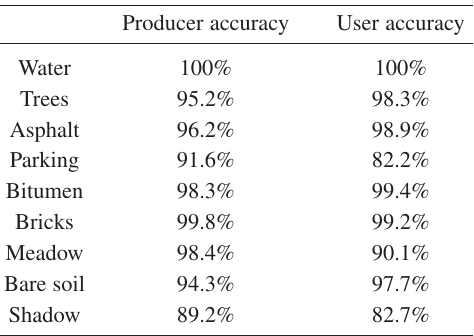
Table III. Accuracy values for Maximum Likeli- hood classifier applied to the test area in fig. 2. Producer accuracy